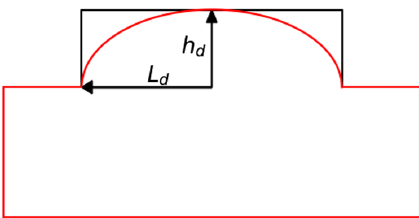
FIG. 6. Sketch showing the geometry of small welding defects on the surface of the vacuum chambers. The black line shows a pessimistic geometry to be modeled, whereas the rounded shape is more realistic.